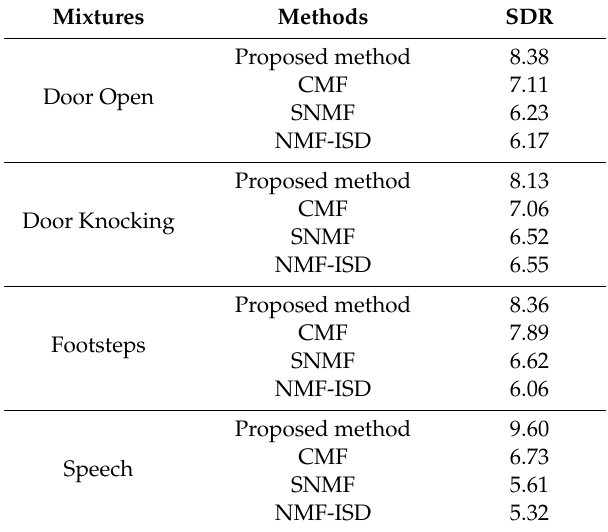
Table 2. Comparison of average SDR and SIR performance on three types of mixtures between SCICA, NMF-ISD, SNMF, CMF, and the proposed method.